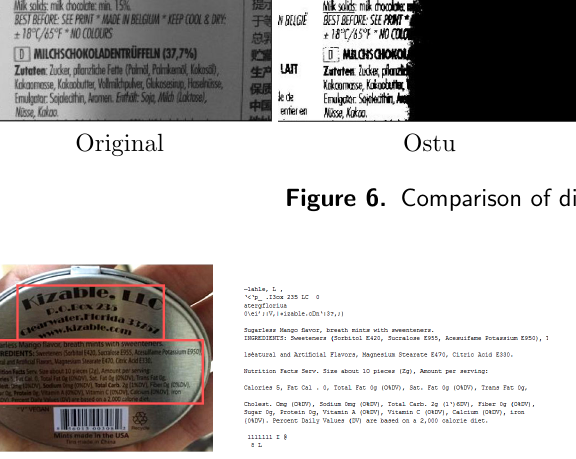
Figure 7. left: Text region detection. The red colored box indicates the detected regions containing character. right: the corresponding scrambled OCR results.